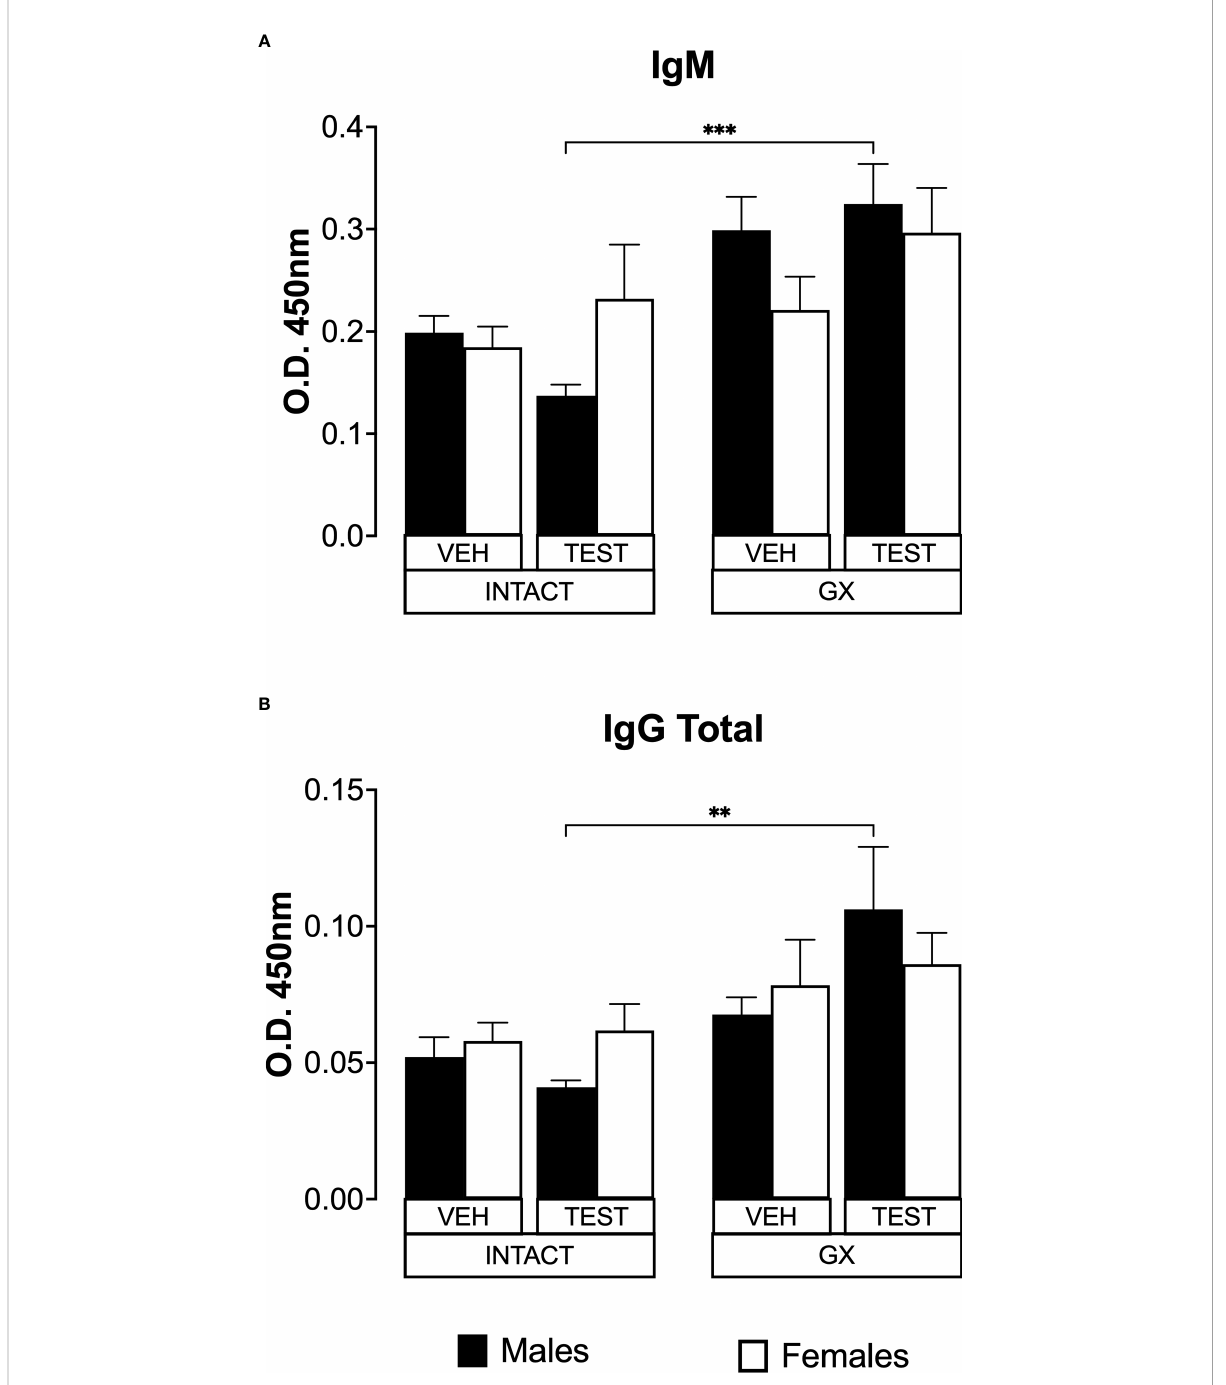
FIGURE 8 Testosterone or gonadectomy did not affect the IgM or IgG levels in mice infected with berghei ANKA. We used 8 groups of males and 8 groups of females, 4 groups of each sex were gonadectomised (GX), and the other 4 groups were left intact; four weeks after surgery, two groups of intact and two GX mice of each sex were administered testosterone for 3 weeks, the other two received vehicle for the same time. Finally, one intact (INTACT) and one GX group treated with testosterone of each sex were infected with P. berghei ANKA. The remaining groups were injected with PBS as infection controls. On day 8 post-infection, mice were sacri fi ced, blood was collected, and plasma used to assess the concentration of IgM and IgG. Histogram in (A) represents the mean ± SEM of IgM plasma levels and the histogram in (B) represents the mean ± SEM of total IgG plasma levels of the vehicle (VEH) or testosterone (TEST), intact (INTACT) or gonadectomised (GX) groups. Statistical differences were calculated using the Kruskal-Wallis test with a Dunn ’ s post hoc (**) represent statistical signi fi cance between groups p<0.01; and (***) p<0.001 (n = 10). The whole experiment was conducted in duplicate (n =